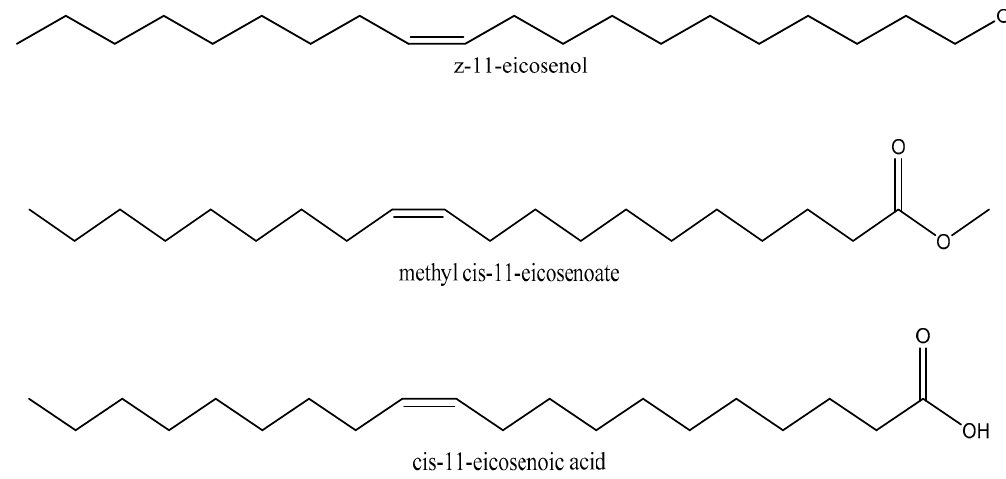
Figure 1. Chemical structures of (Z)-11-eicosenol, methyl cis-11-eicosenoate and cis-11-eicosenoic acid.